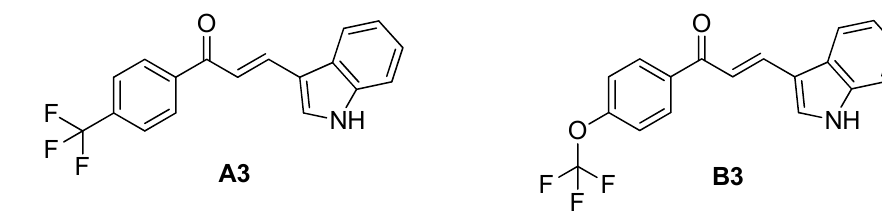
Figure 4. Structures of fluorinated chalcones A3 and B3.